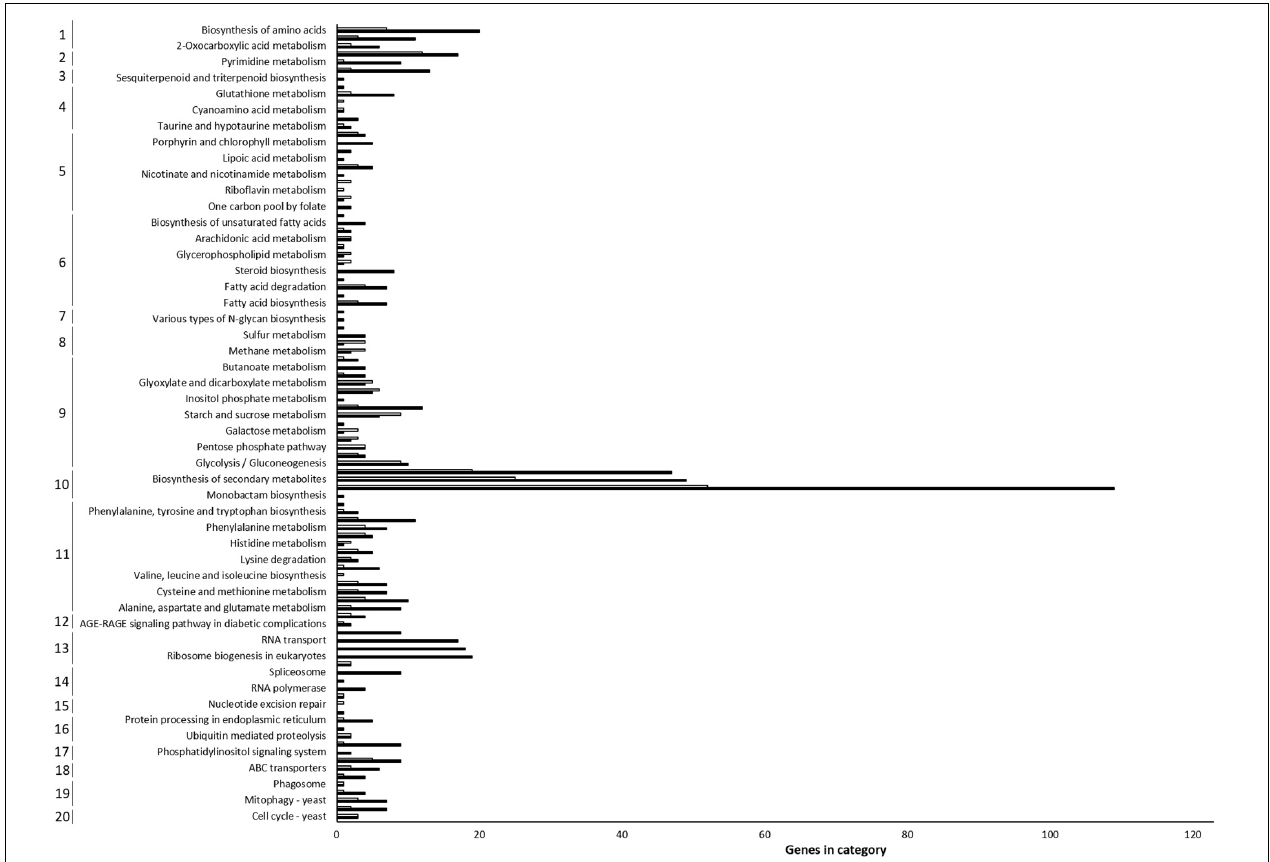
FIGURE 4 | KEGG pathway enrichment analysis. Significant KEGG pathways among up-regulated (black) and down-regulated (white) DEGs are shown. DEGs were assigned to 20 categories, indicated by numbers on the left according to the biological pathway: (1) overview; (2) nucleotide metabolism; (3) metabolism of terpenoids and polyketides; (4) metabolism of other amino acids; (5) metabolism of cofactors and vitamins; (6) lipid metabolism; (7) glycan biosynthesis and metabolism; (8) energy metabolism; (9) carbohydrate metabolism; (10) biosynthesis of other secondary metabolites; (11) amino acid metabolism; (12) endocrine and metabolic diseases; (13) translation; (14) transcription; (15) replication and repair; (16) folding, sorting and degradation; (17) signal transduction; (18) membrane transport; (19) transport and catabolism; and (20) cell growth and